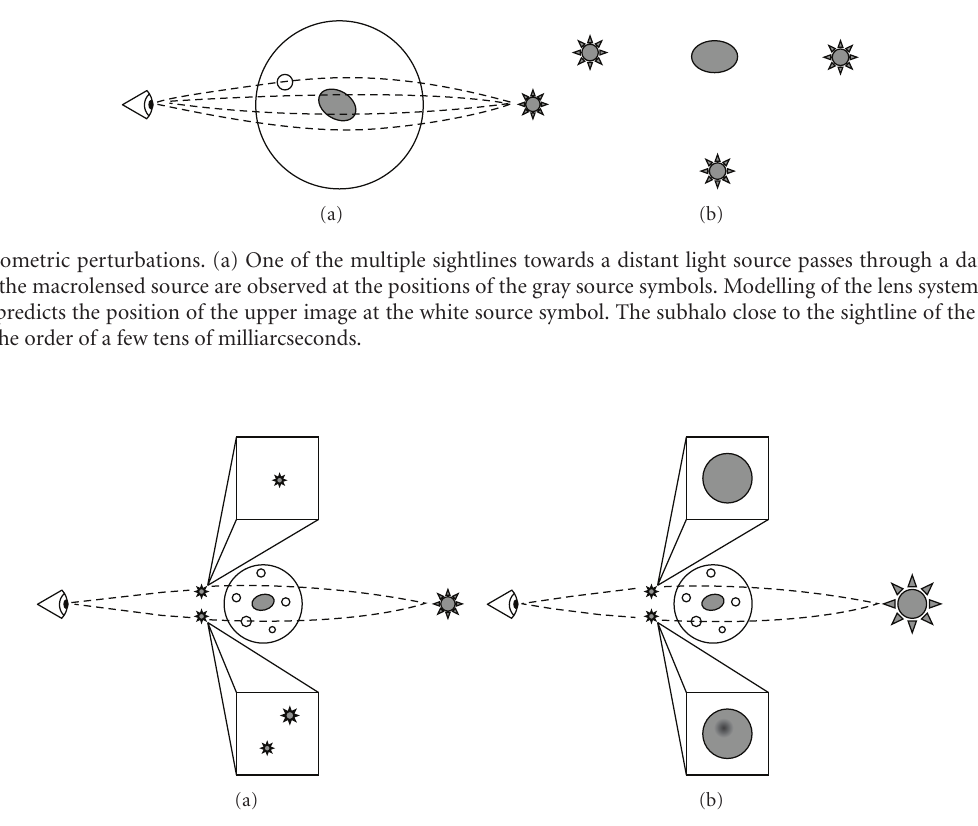
Figure 6: A foreground galaxy with a dark matter halo produces multiple macroimages of a background light source. A subhalo located in the dark halo intercepts one of these macroimages, which may give rise to (a) additional image small-scale splitting of the a ff ected macroimage if the source is su ffi ciently small, or (b) a mild distortion in the a ff ected macroimage, if the source is